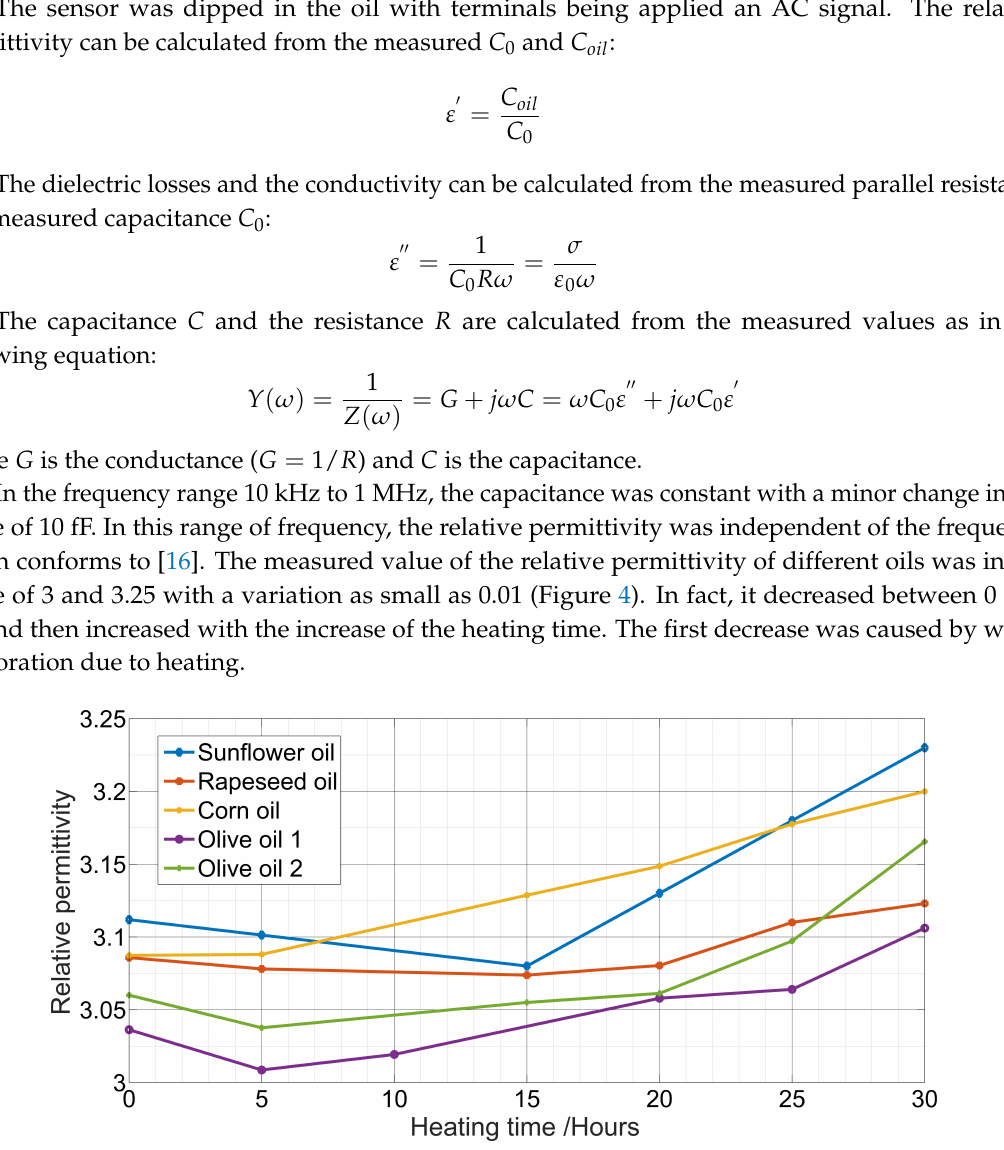
Figure 4. Measured relative permittivity vs. the heating